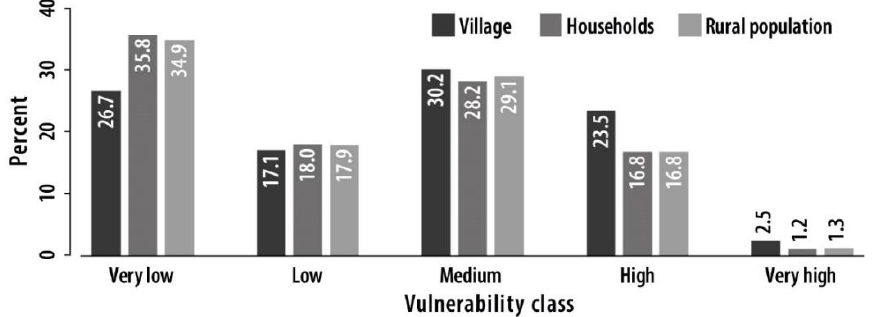
Figure 6. Percentage of villages, households, and rural population affected by different levels of SDS vulnerability in Iran.